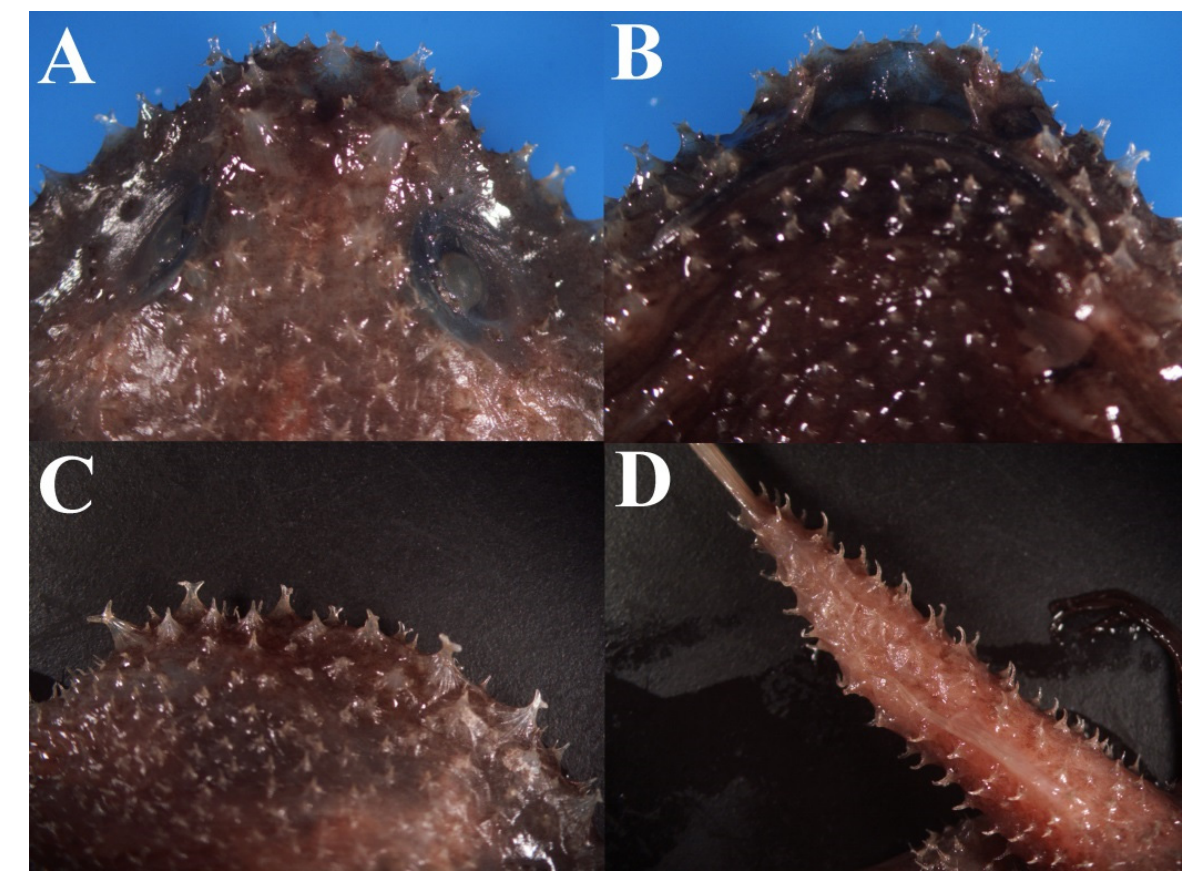
Figure 27. Halieutopsis oblonga (Smith and Radcliffe, 1912), from FRIP 0516. ( A ). Dorsal view of front head. ( B ). Ventral view of front head. ( C ). Dorsal view of left disk margin, with arrow pointing to subopercular tubercle. ( D ). Ventral view of tail.